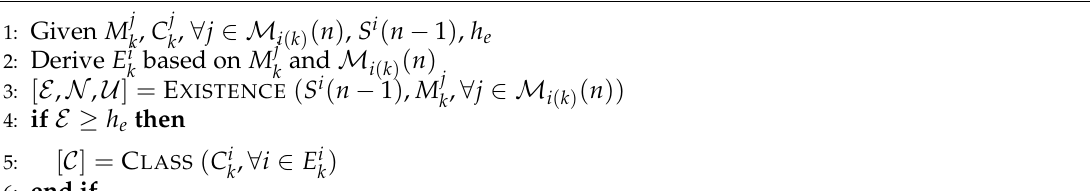
Algorithm 3 Decision-making for vehicle i about object k